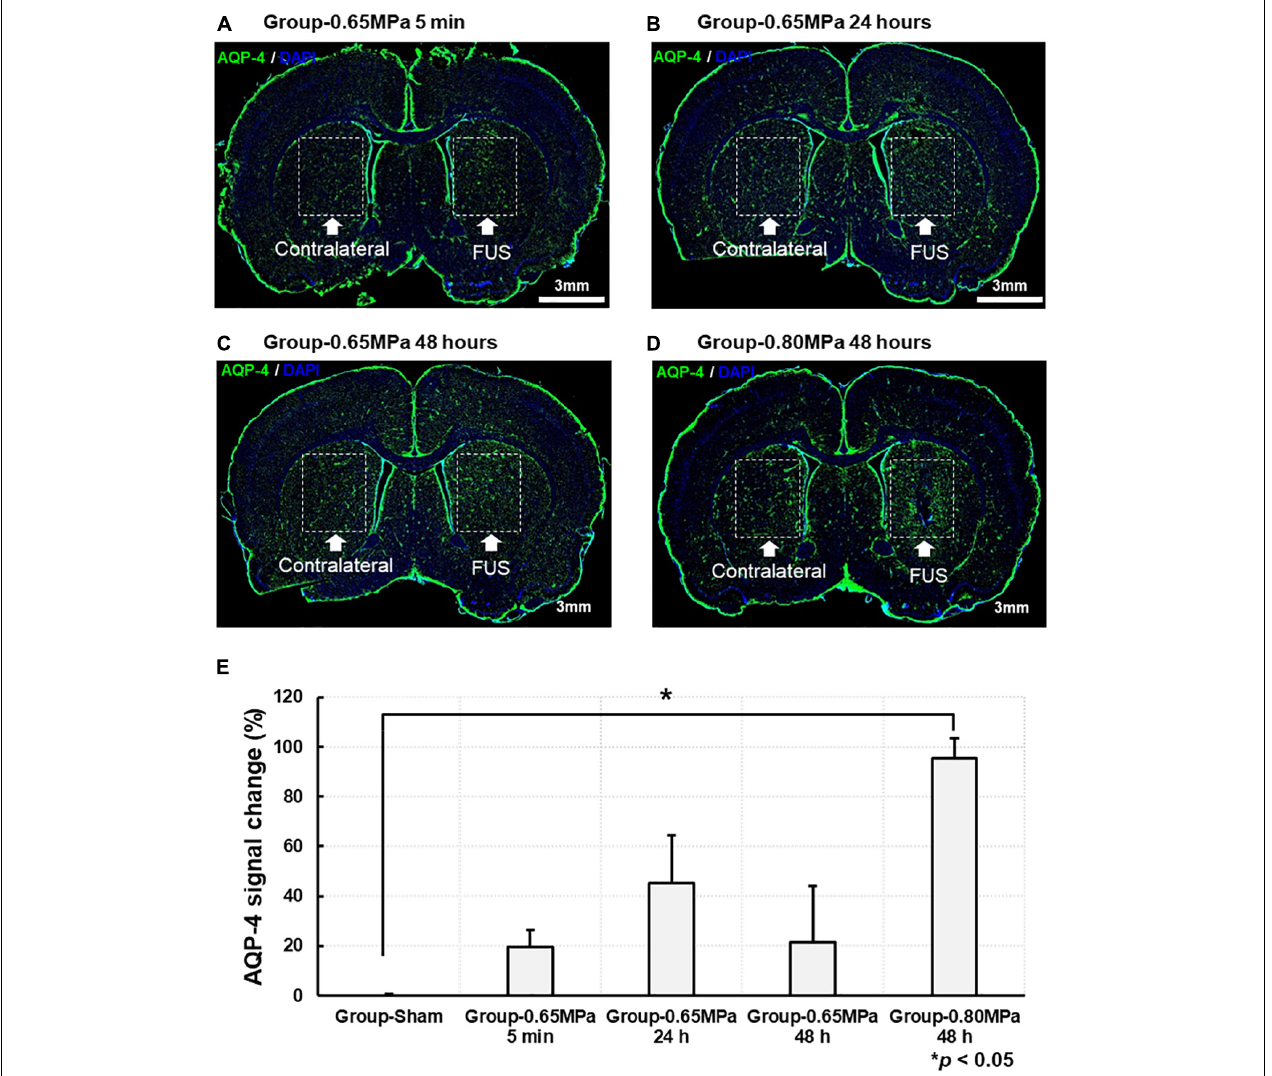
FIGURE 6 | Representative AQP-4 immunostaining at caudate putamen for group-0.65 MPa and group-0.80 MPa. The brain section was stained with AQP-4 for group-0.65 MPa at 5 min (A) , 24 h (B) , and 48 h (C) and group-0.80 MPa at 48 h (D) after sonication. Green and blue fluorescence indicate the AQP-4 expression and the DAPI, respectively. Scale bar: 3 mm. (E) Comparison of the AQP-4 signal change is analyzed between group-sham, group-0.65 MPa, and group-0.80 MPa. * p <